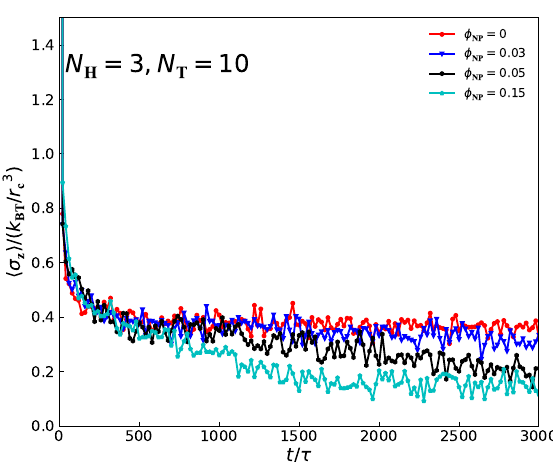
Figure 8. The average tensions ( (cid:104) σ z (cid:105) ) along the z -direction as a function of time for lamellar structures with φ NP = 0, φ NP = 0.03, φ NP = 0.05 and φ NP =